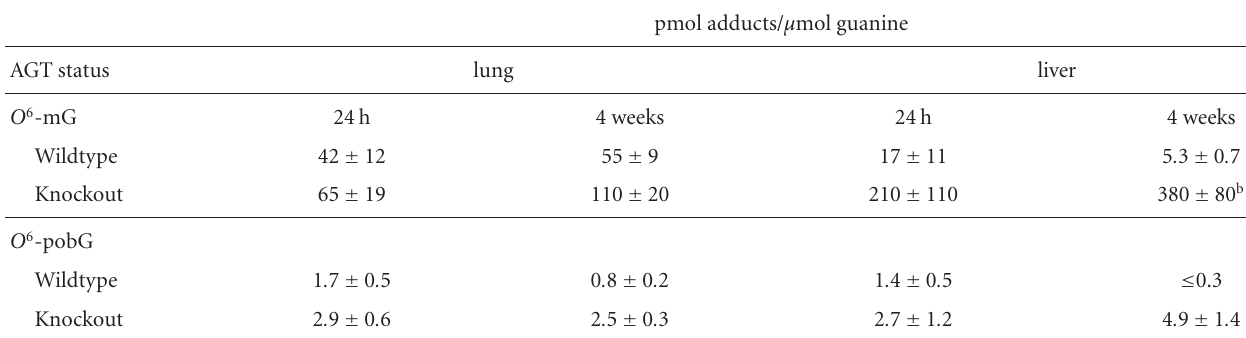
Table 3: Levels of O 6 -mG and O 6 -pobG in lung and livers of NNK-treated wild-type and AGT knockout mice a